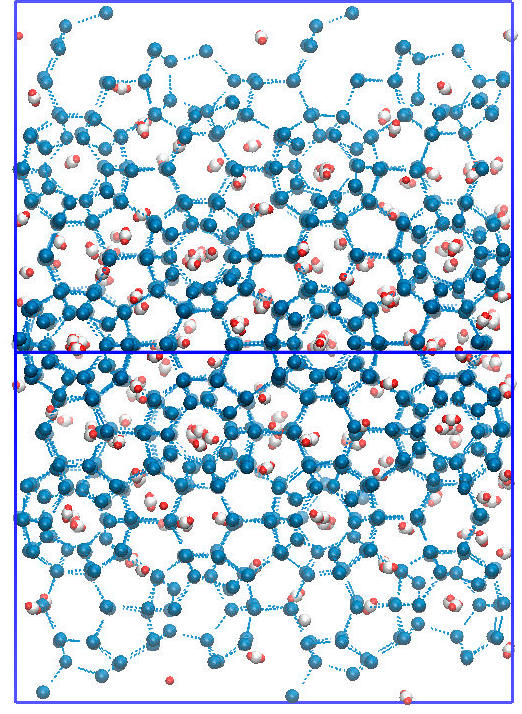
Figure 1. Schematic of a hydrogen/Deuterium hydrate in a bulk simulation box.